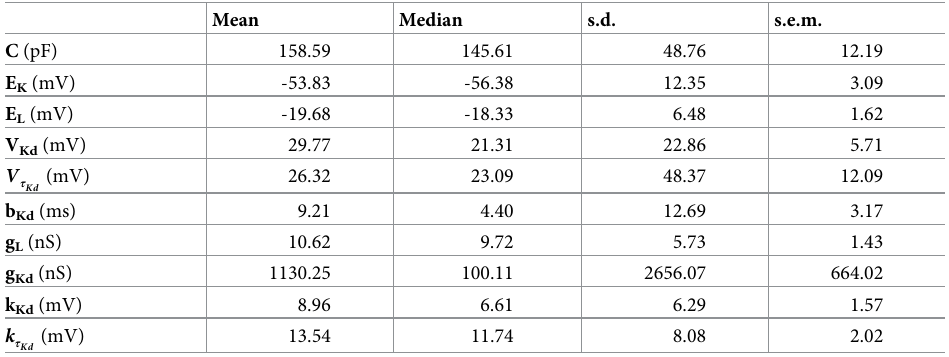
Table 2. Statistics of fitted parameters (n = 16) for deciliated cells (Boltzmann model with two gates).